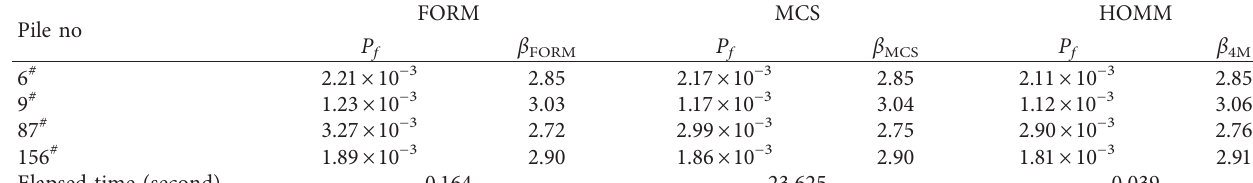
Table 5: The reliability index and failure probability result of three methods.